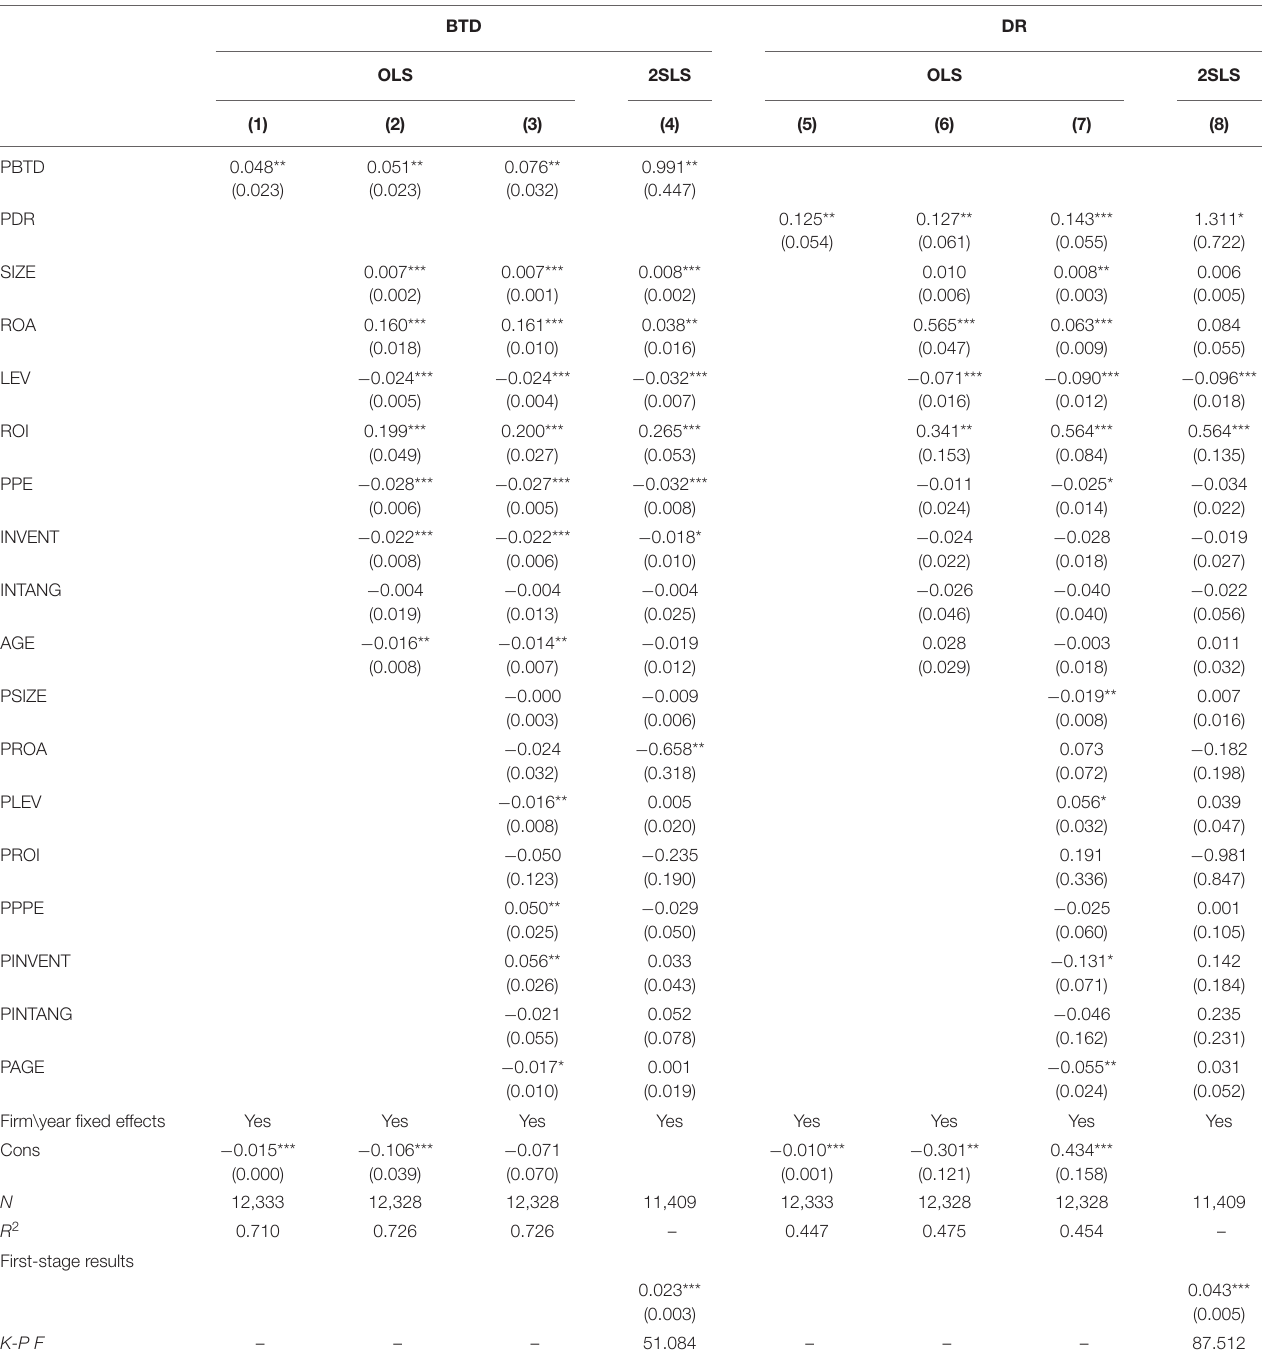
TABLE 2 | Existence of regional peer effects in corporate tax avoidance.